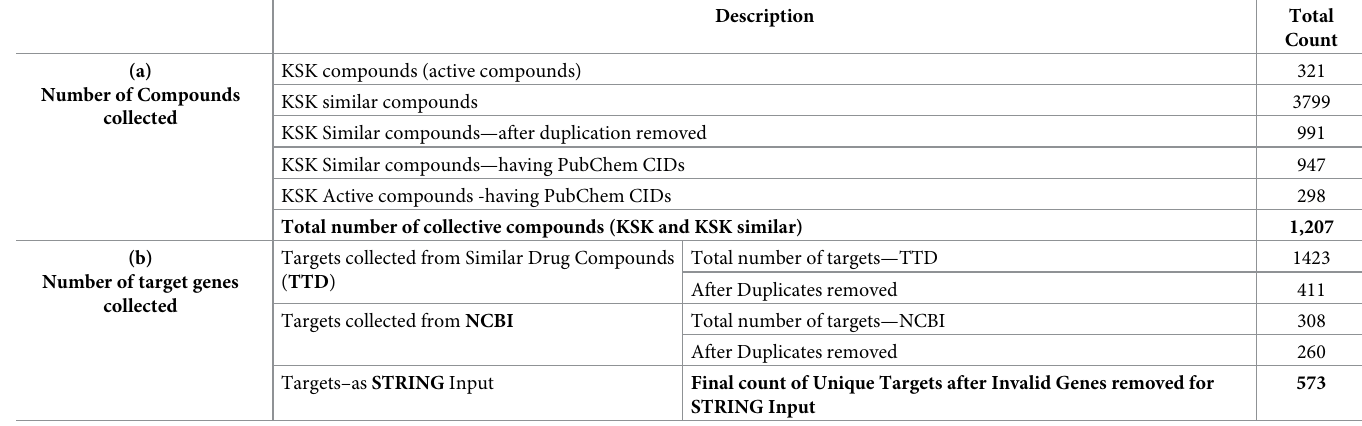
Table 1. Collection of compounds and target genes for the study. (a) shows the total count of KSK active compounds and total count of KSK similar compounds. There were 991 similar compounds in total in which 44 were removed for not having PubChem CIDs and 321 active compounds in total in which 23 were removed as they do not have PubChem CIDs. Totally 1,245 compounds were listed from which 38 duplicates were removed and 1,207 compounds were collected finally; (b) shows the number of target genes collected from TTD and NCBI